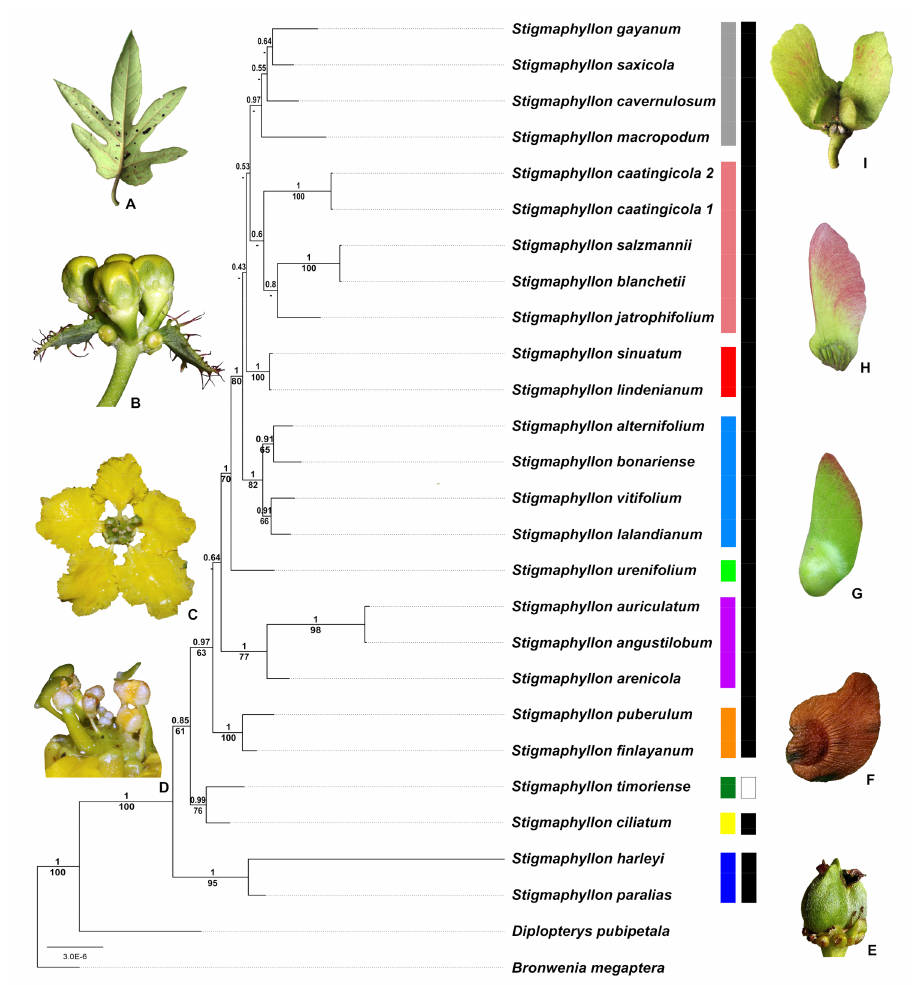
Figure 1. Phylogram from the combined analysis of nuclear and ribosomal markers for Stigmaphyllon . Posterior probabilities are shown above branches and bootstrap values below branches. Black bars represent S. subg. Stigmaphyllon and the white bar represents S. subg. Ryssopterys . (dark blue bar) S. paralias group; (yellow bar) S. ciliatum group; (dark green bar) S. subg. Ryssopterys ; (orange bar) S. finlayanum group; (purple bar) S. auriculatum group; (light green bar) S. urenifolium group; (light blue bar) S. lalandianum group; (red bar) S. sinuatum group; (pink bar) S. blanchetii group; (grey bar) S. saxicola group. ( A ) adaxial surface of a leaf of S. angustilobum A.Juss. ( B ) Umbel of S. ciliatum (Lam.) A.Juss. in side view evidencing ciliate reduced leaves associated with the inflorescence. ( C ) open flower of S. ciliatum in frontal view. ( D ) androecium and gynoecium of S. ciliatum in side view, ( E ) mericarp of S. paralias A.Juss. in side view. ( F ) winged mericarp of S. ciliatum in side view. ( G ) winged mericarp of S. auriculatum (Cav.) A.Juss. in side view. ( H ) winged mericarp of S. saxicola C.E.Anderson in side view. ( I ) winged mericarps of S. blanchetii in side view (photographs by